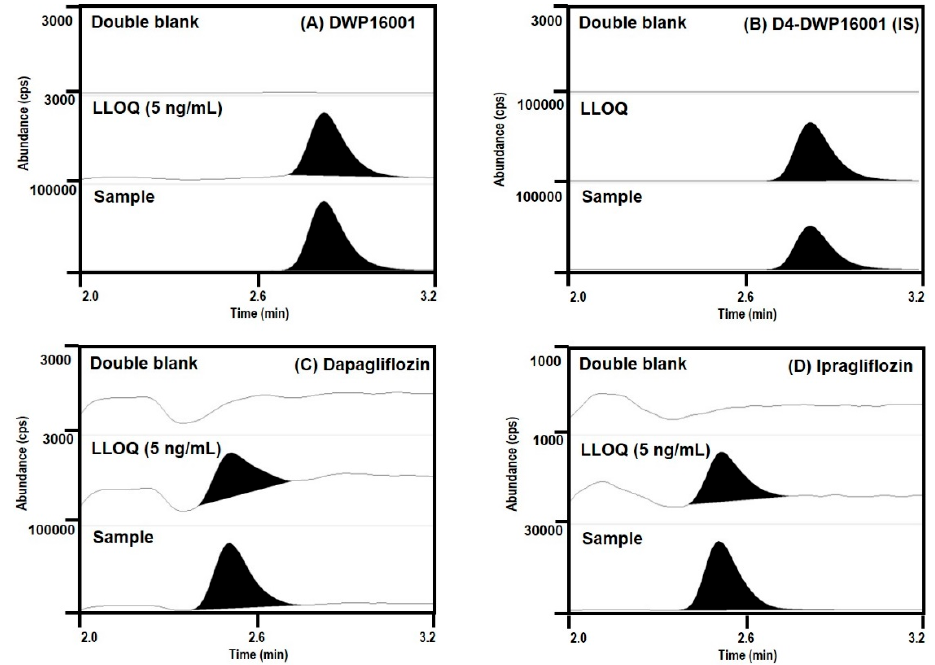
Figure 2. Product ion spectra of ( A ) DWP16001, ( B ) D4-DWP16001 (IS), ( C ) dapagliflozin, and ( D ) ipragliflozin.